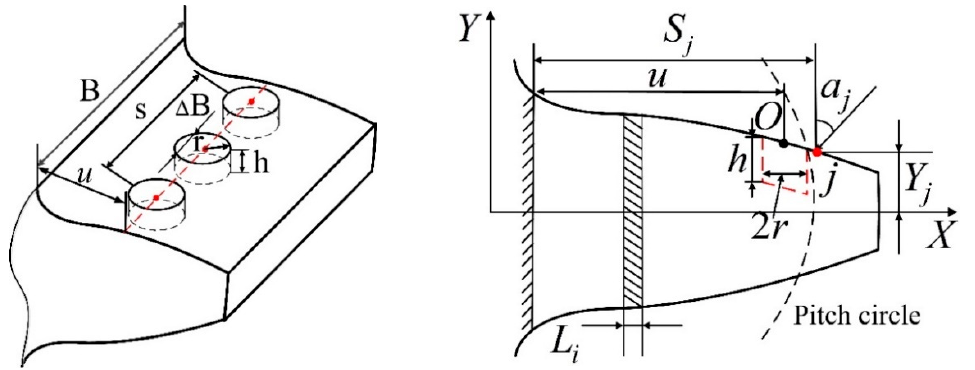
Figure 3. Geometric model of the spalling tooth.